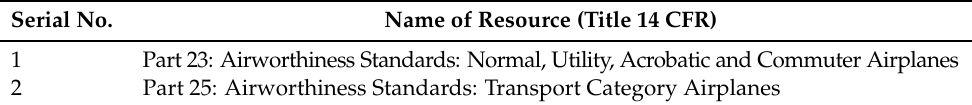
Table 2. Resources used for the creation of aerospace requirements classification corpus. Serial No.